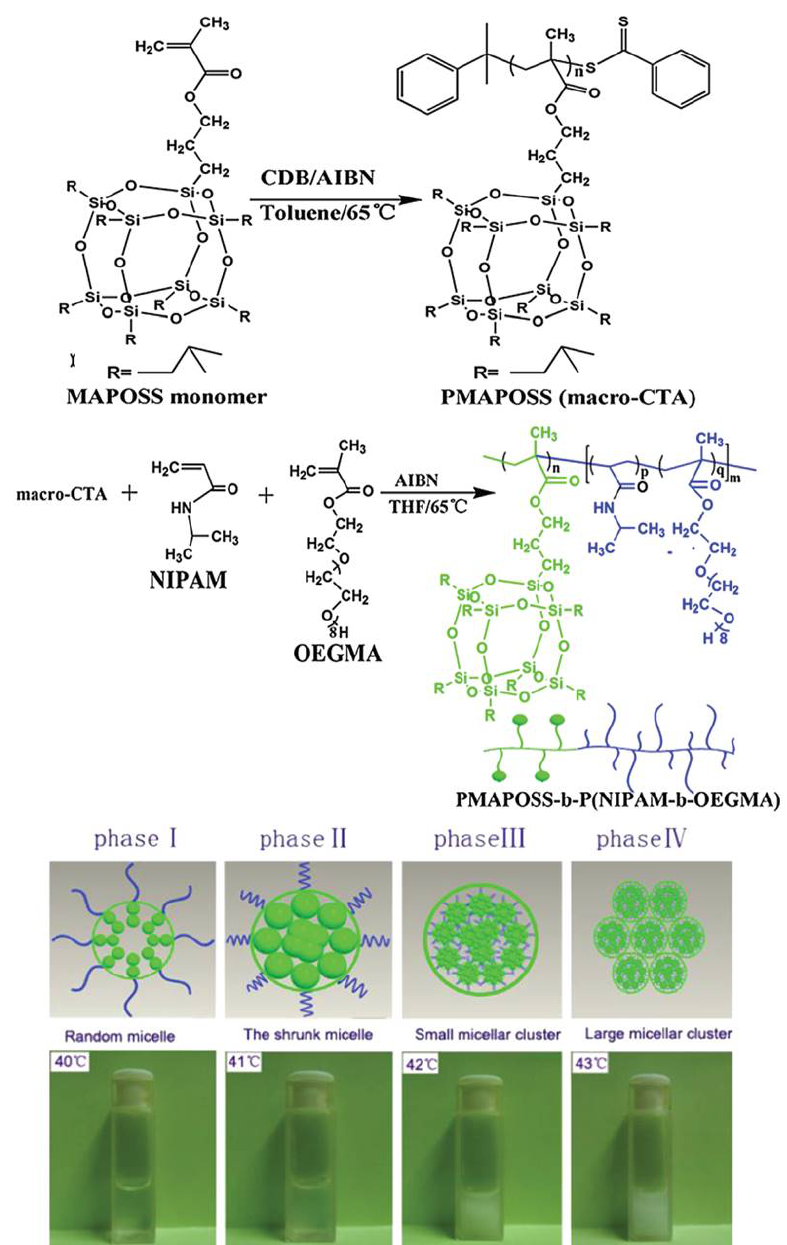
Figure 3. Synthetic route of the PMAPOSS- b -P(NIPAM- co -OEGMA) block copolymer via reversible addition fragmentation chain transfer (RAFT) polymerization and images of the phase changes for the PMAPOSS- b -P(NIPAM- co -OEGMA) micelle with solution heating and the macroscopic phase transition of PMAPOSS 9 - b -P(NIPAM 180 - co -OEGMA 15 ) solution with the temperature ranging from 40 °C to 43 °C. CDB, AIBN, MAPOSS and macro-CTA represents for cumyl dithiobenzoate, 2,2 ′ - azoisobutyronitrile, methacrylate isobutyl POSS and PMAPOSS, respectively. Reprinted with permission from [104]. Copyright (2014) John Wiley and Sons.